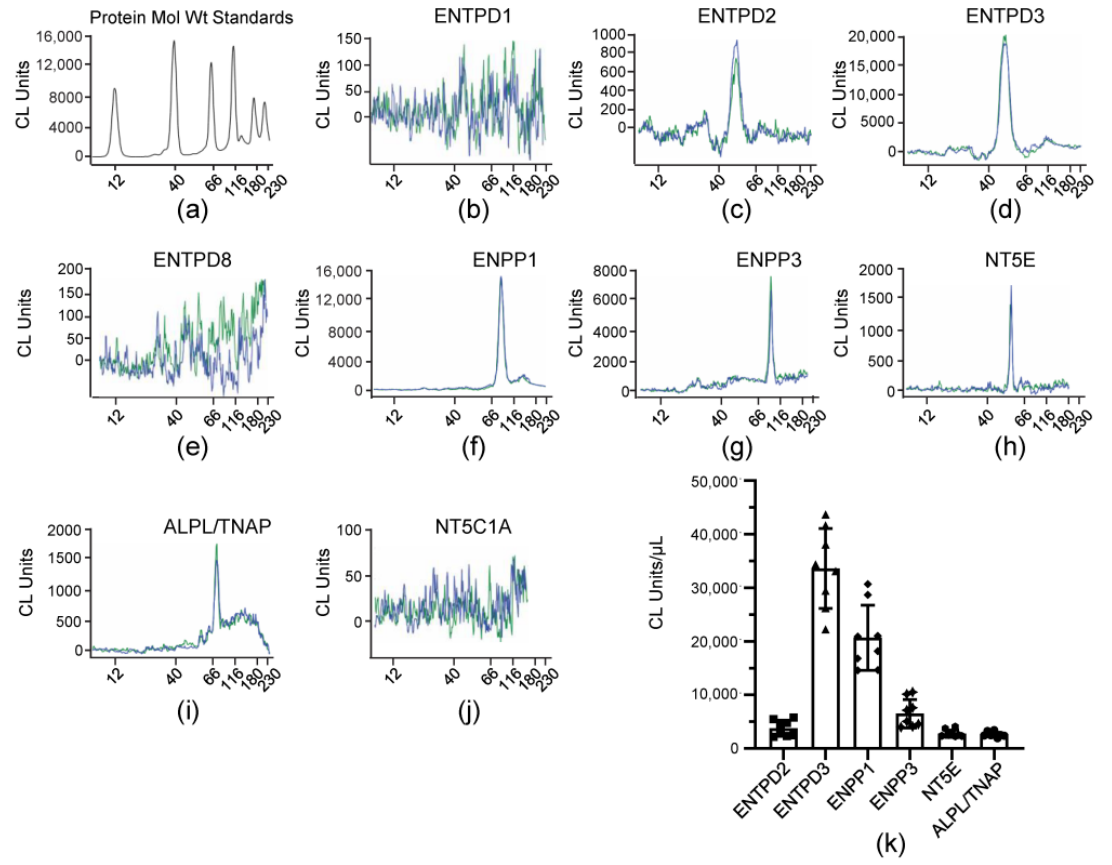
Figure 6. Protein expression levels in ILS collected at the end of filling of detrusor-free bladder preparations. ( a – j ) Representative immunoelectropherograms (duplicates) of nucleotidases evaluated using ProteinSimple Wes. Each antibody was diluted 100-fold and each well contained 3 µ L of ILS sample. ( k ) Scatter plots of AUC of chemiluminescence (CL) signals normalized per µ L loaded ILS sample ( n = 8); n , number of bladder preparations. Statistical significance is described in Section 3.5.